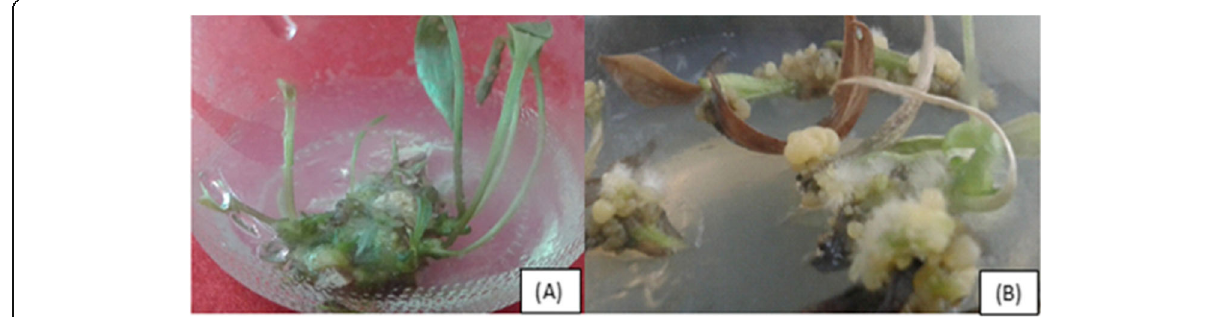
Fig. 1 Regenerative capacity of oriental lily affecting by different plant growth regulators. a Direct regenerated shoots on MS supplemented with